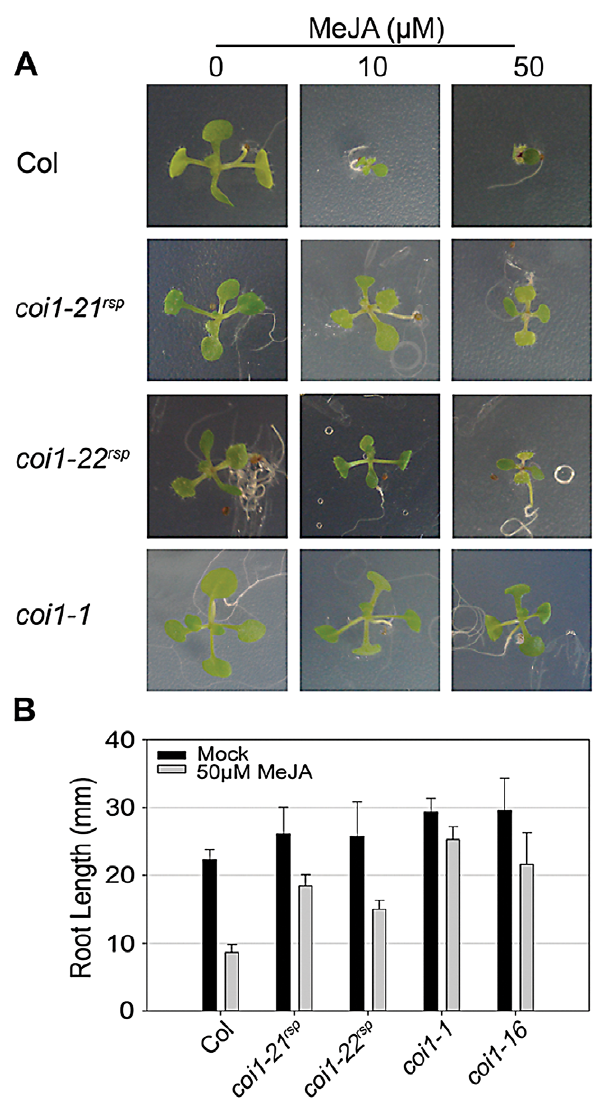
Figure 5. coi1 rsp alleles are insensitive to JA. (A) Seedlings of the indicated genotypes were grown on MS medium (control) or medium containing 10 or 50 m M MeJA. (B) Inhibition of root elongation by 50 m M MeJA in at least twenty seedlings of indicated genotypes. This assay was performed independently three times with similar results.